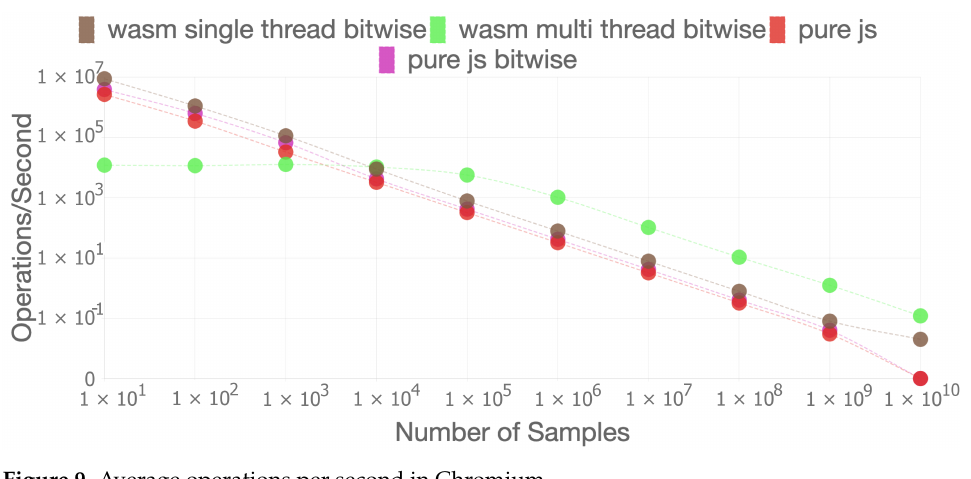
Figure 9. Average operations per second in Chromium.